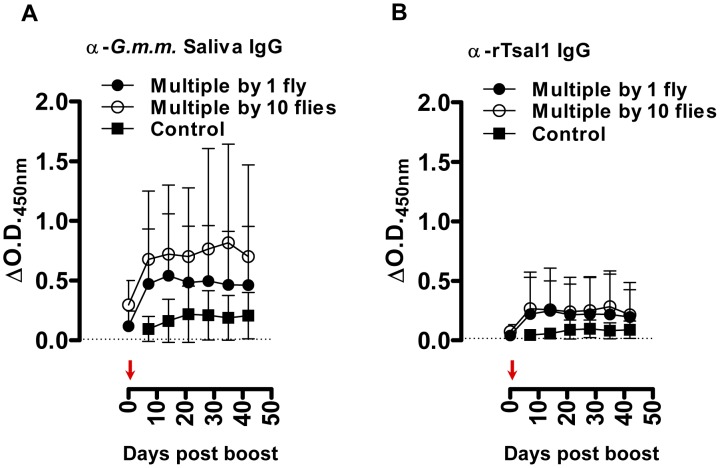
Effect of boosting in mice after a long period of non-exposure.Evolution of the anti-G. m. morsitans saliva IgG responses (A) and the anti-rTsal1 IgG repsonses (B) was evaluated in mice (n = 6/group) originally exposed to the bites of a single or 10 flies and re-exposed to a single tsetse fly bite after a 1-year period of non-exposure (indicated by an arrow). Controls are the naive mice exposed to a single bite as depicted in Figure 1. The original control animals (n = 3) were not exposed and served as negative controls (dotted line). Presented data are mean ΔO.D.450 nm values with the 95% CI obtained with a 1∶1600 dilution of the individual plasmas.